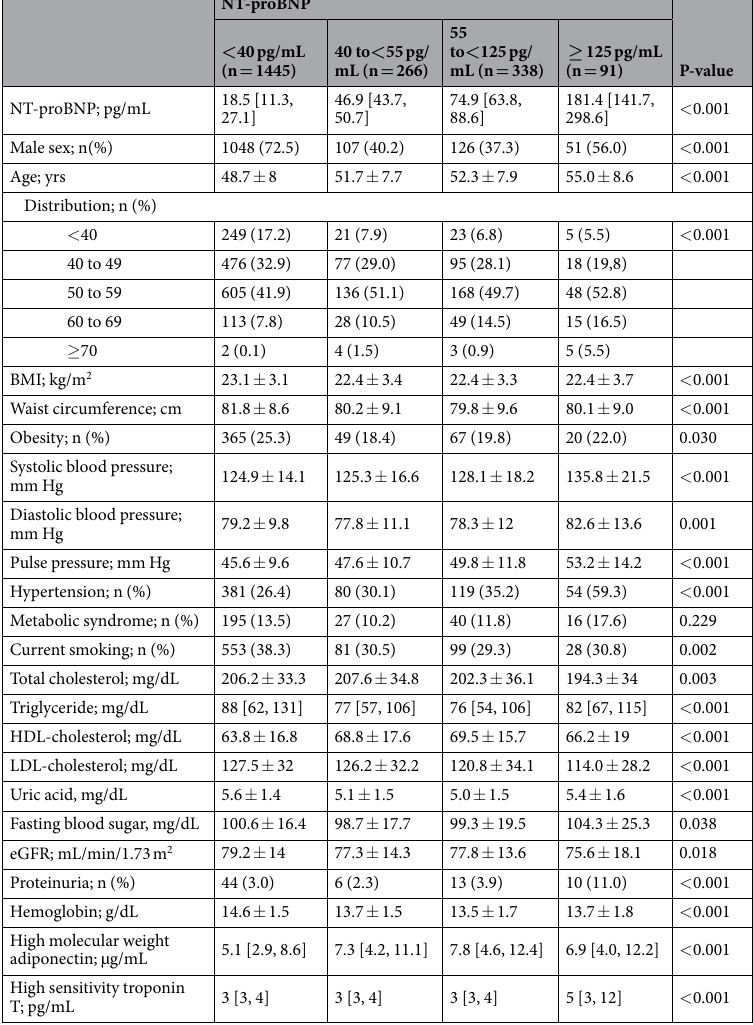
Table 2. Factors correlated with NT-proBNP levels by ANOVA. Data are shown as Mean ± SD, Median [IQR], or n (%). P values were calculated by ANOVA for variables with normal distribution and chi-square test for frequency of variable. In the analysis of skewed variables, P values were calculated after transfer to logarithms by ANOVA. Abbreviations, see Table